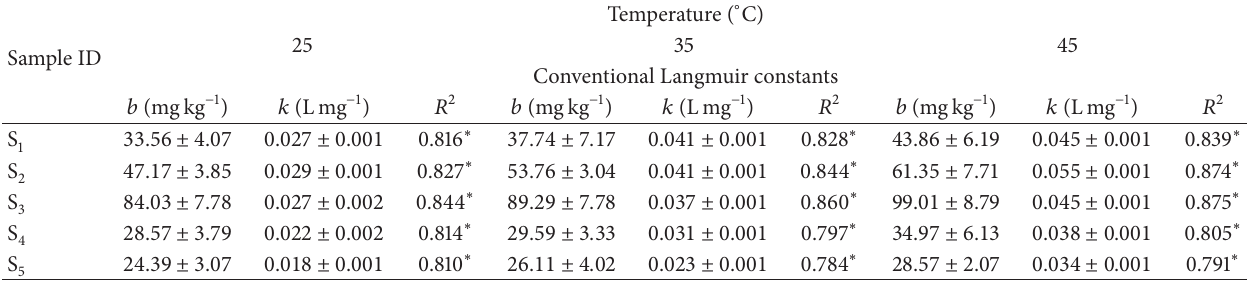
Table 2: Conventional Langmuir constants of Cd sorption in soils (data represent mean of tree replications ± SD).